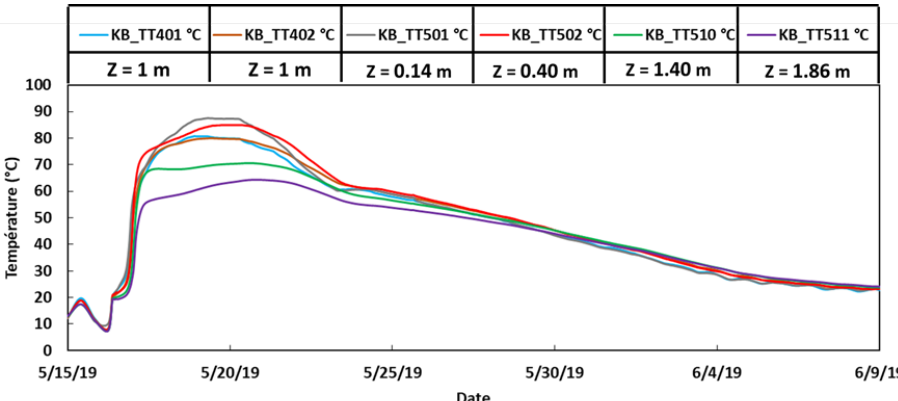
Figure 17. Temperatures recorded by selected thermocouples inside the block KB during the initial thermal treatment (z refers to the vertical position of the thermocouple, the origin of the 𝑧⃗ axis is located at the center of the top face of the block).